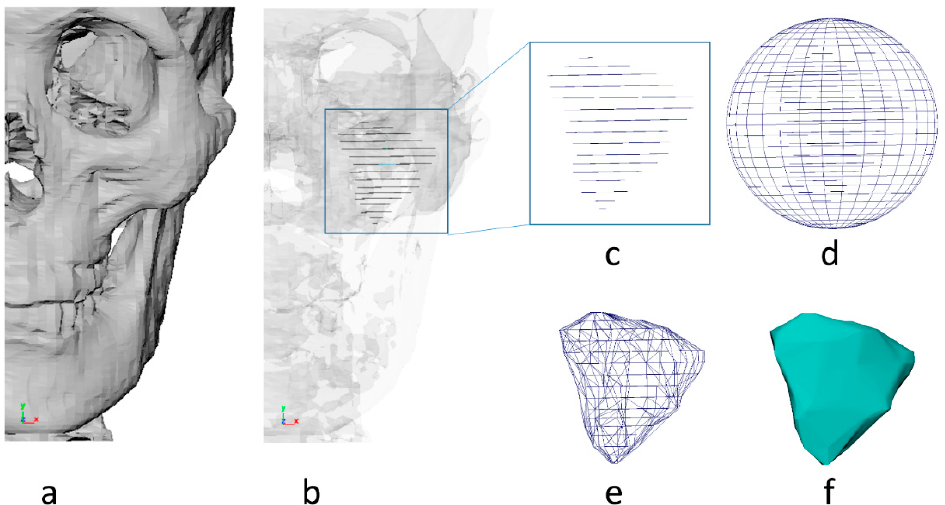
Figure 1. Surface reconstruction of a lateral pterygoid muscle and skull. The lateral pterygoid muscle and skull were initially surface reconstructed ( a ). The skull is transparent to reveal the initial surface models of the lateral pterygoid muscles ( b ). The initial surface models of the lateral pterygoid muscles ( c ). A polyhedron was made ( d ) and formed around the initial surface models of the lateral pterygoid ( e ). Then, the surface model of the lateral pterygoid was realistically and smoothly reconstructed ( f ). (Maya, version 2022, www.autodesk.com, accessed on 28 Aug 2021).